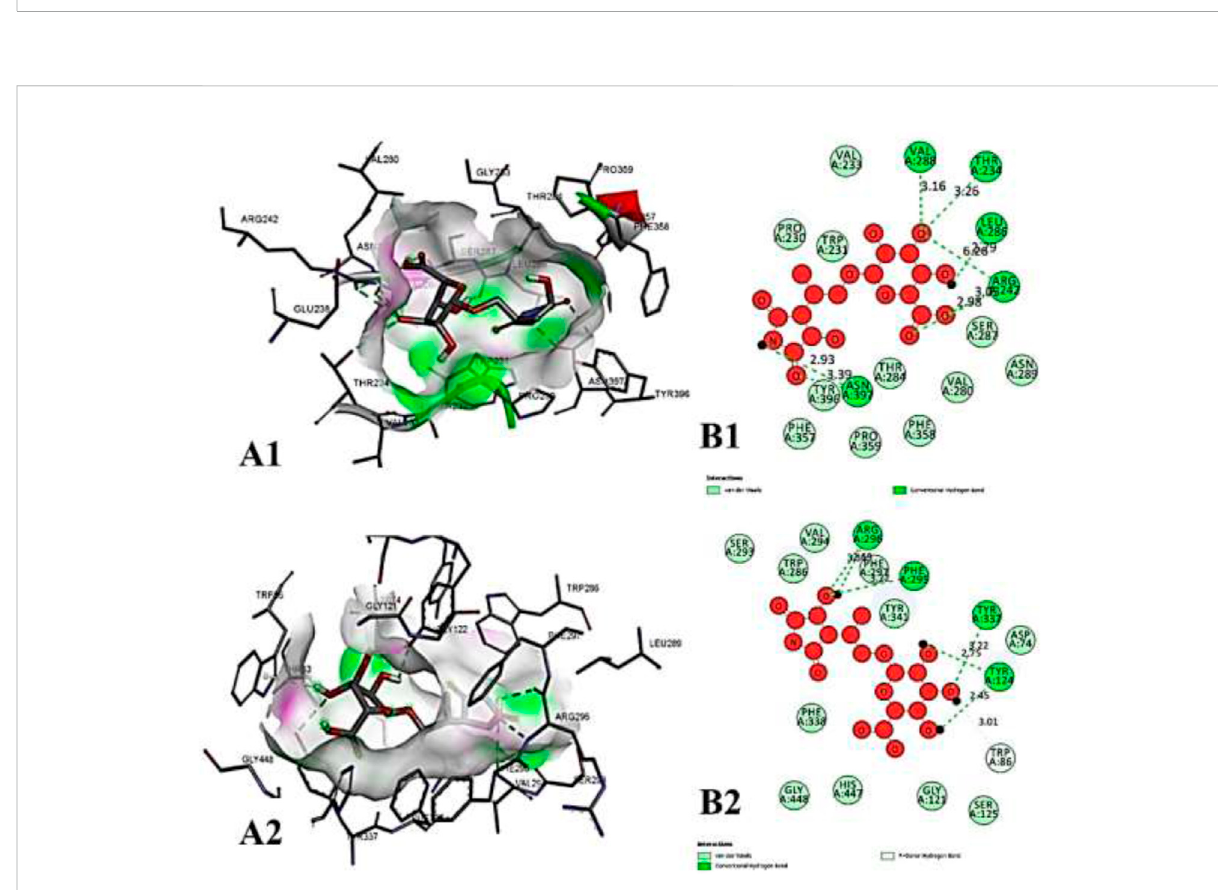
FIGURE 9 The molecular docking interactions of ligand N - acetylmuramic acid with (A) 4AQD and (B) 4EY7 receptors in 2D and 3D representation.